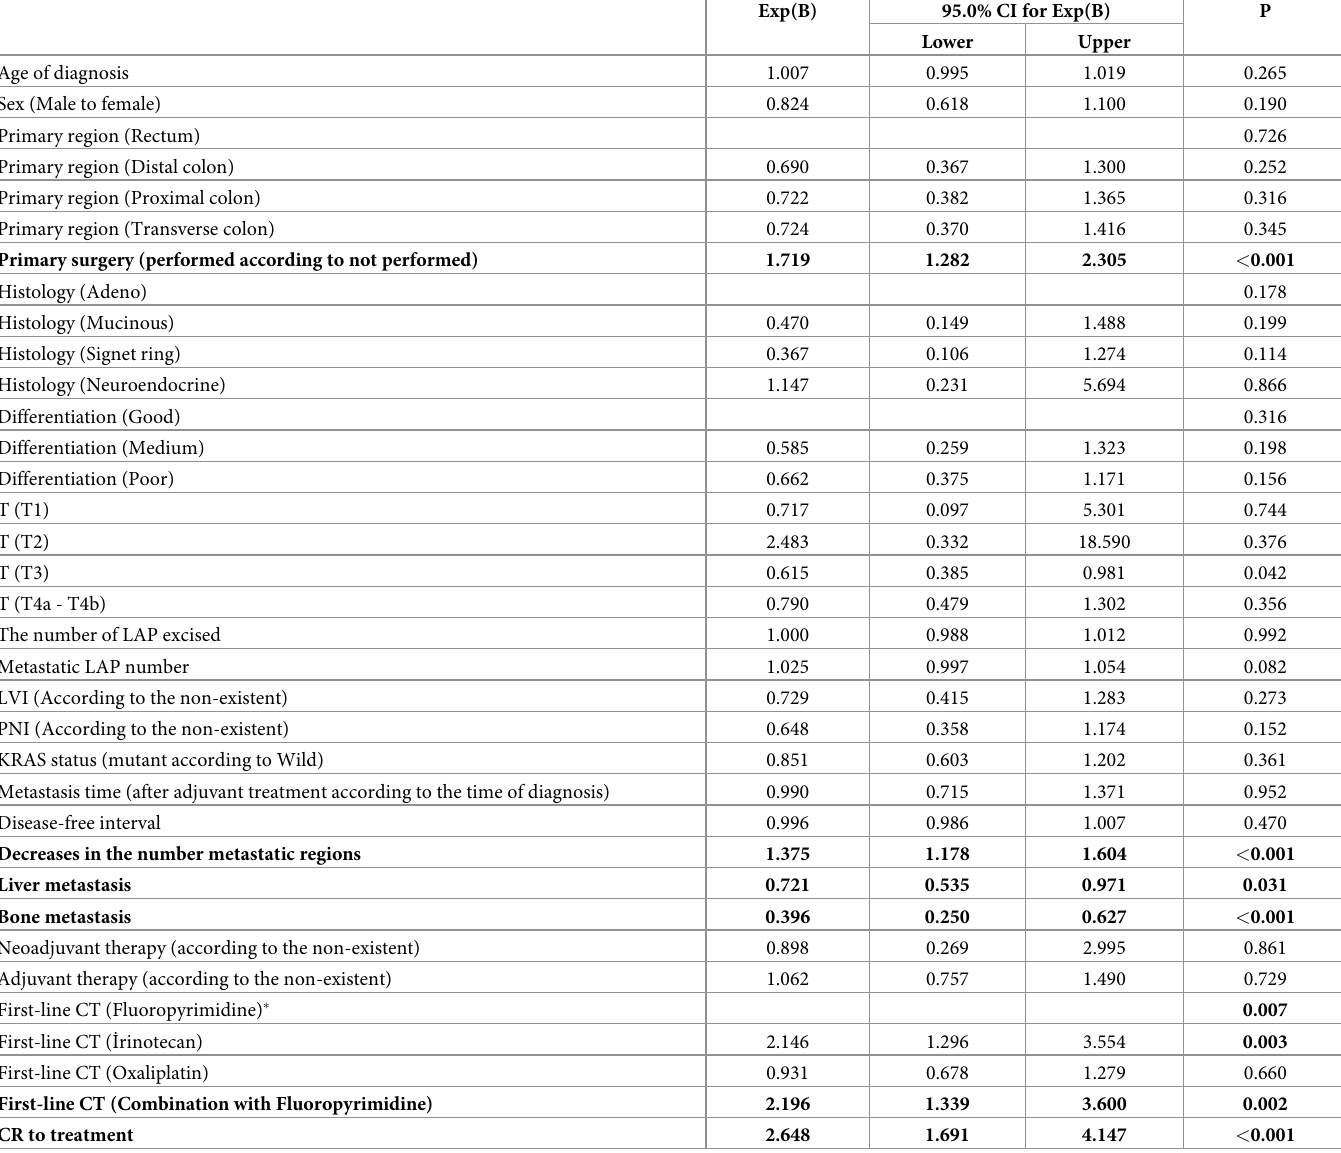
Table 4. According to the univariate analysis (Cox regression analysis), the effect of variables on overall